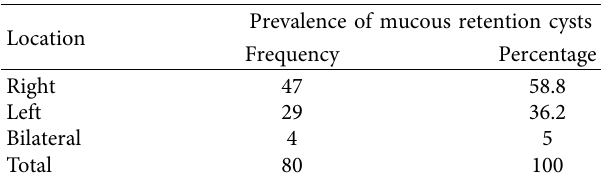
Table 4: The frequency of mucous retention cysts (MRCs) in the population was studied based on